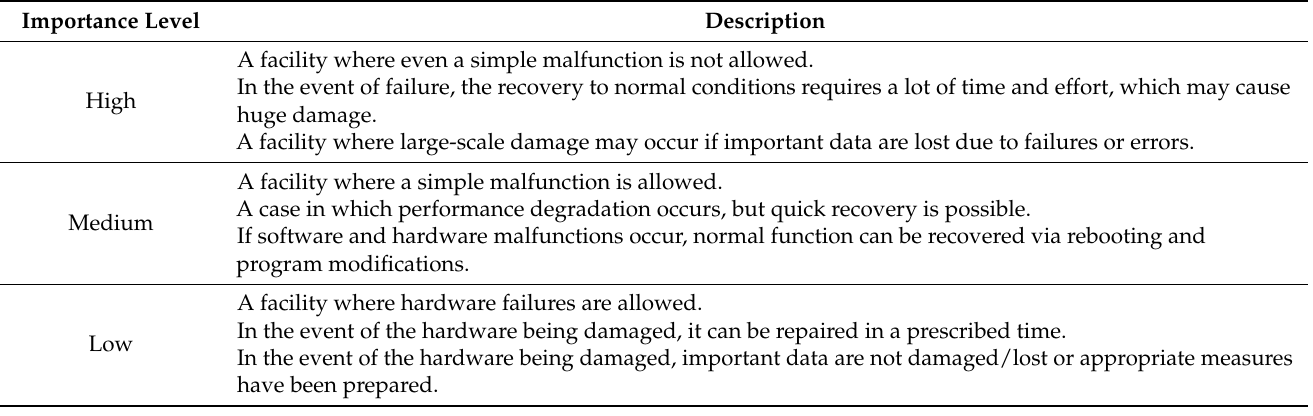
Table 2. Importance level of EMP